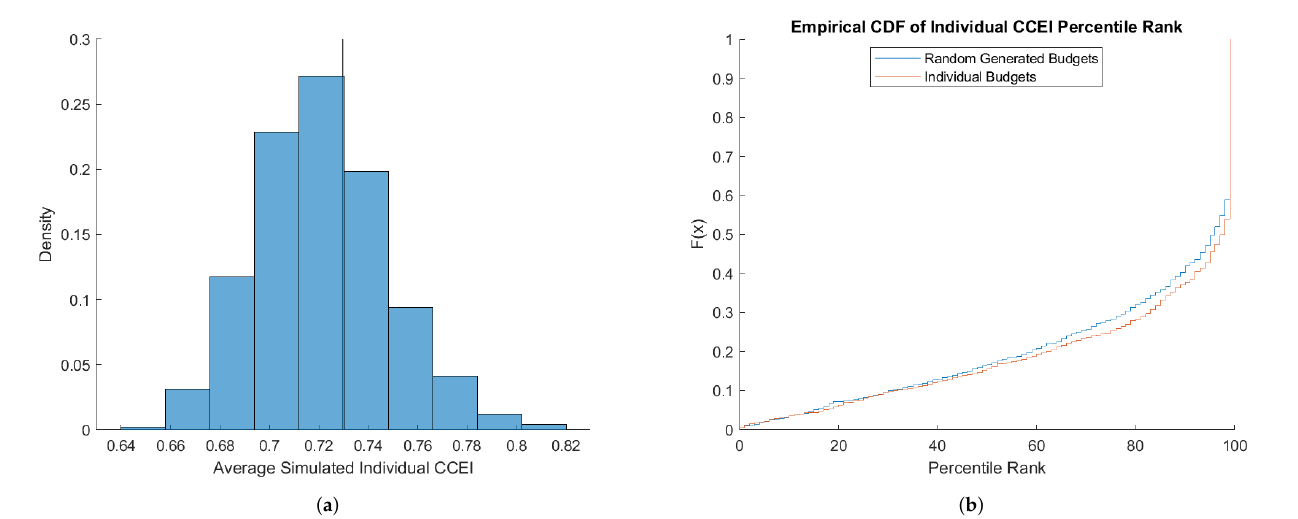
Figure 4. Simulation results for CCEI (CKMS). ( a ) Histogram, ( b ) Percentile